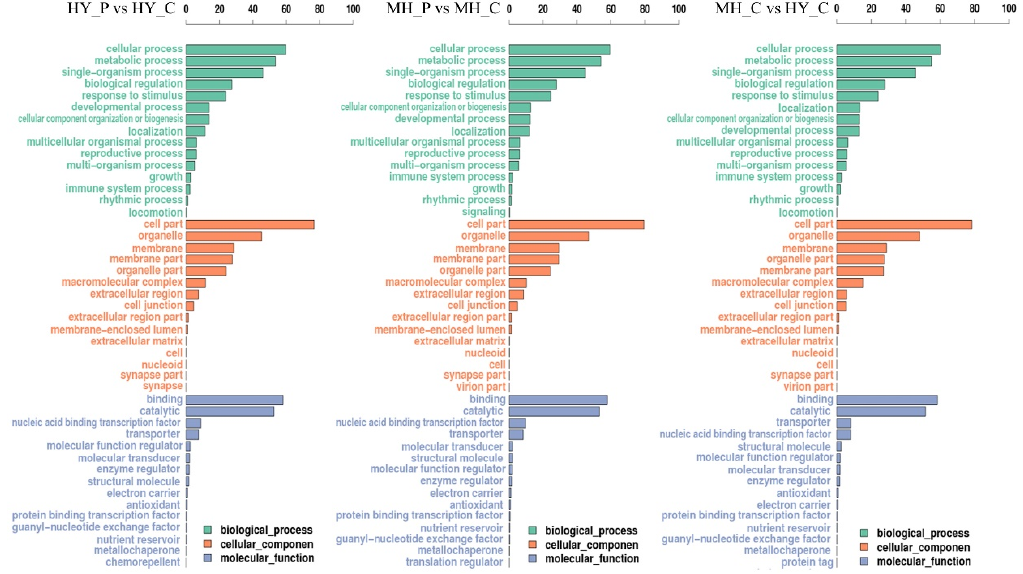
Figure 3. GO-enrichment analysis of the DEGs in comparisons between MH and HY after Psa in- fection.